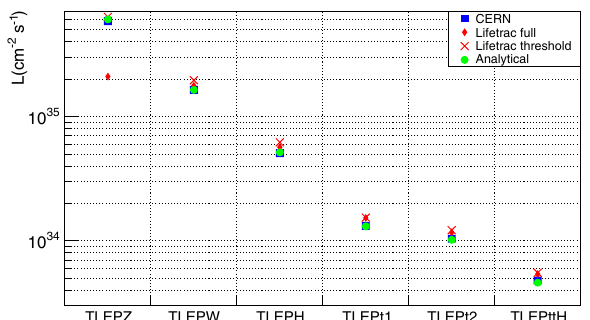
FIG. 1. Luminosity for different scenarios of TLEP operation. Blue squares are taken from Table I, red diamonds are L IFETRAC results with full spectrum of beamstrahlung, red crosses are L IFETRAC results if beamstrahlung is considered for emission of photons with energy higher than acceptance, green dots are our analytical